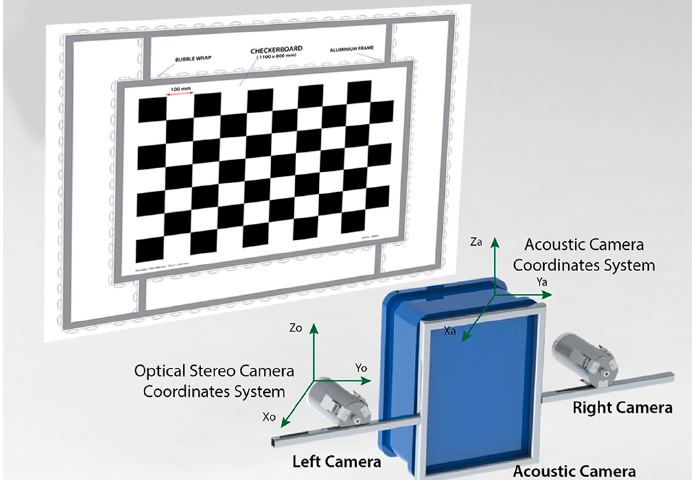
Figure 1. Geometry of the alignment method.